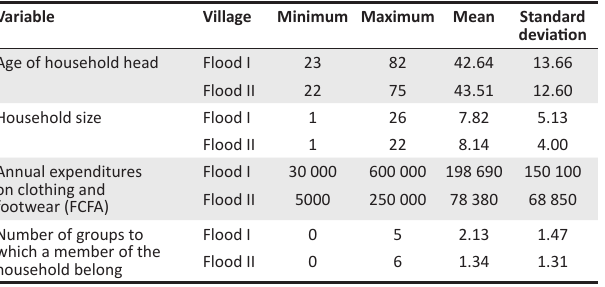
TABLE 1: Descriptive statistics of the sampled households by flood incidence. Variable